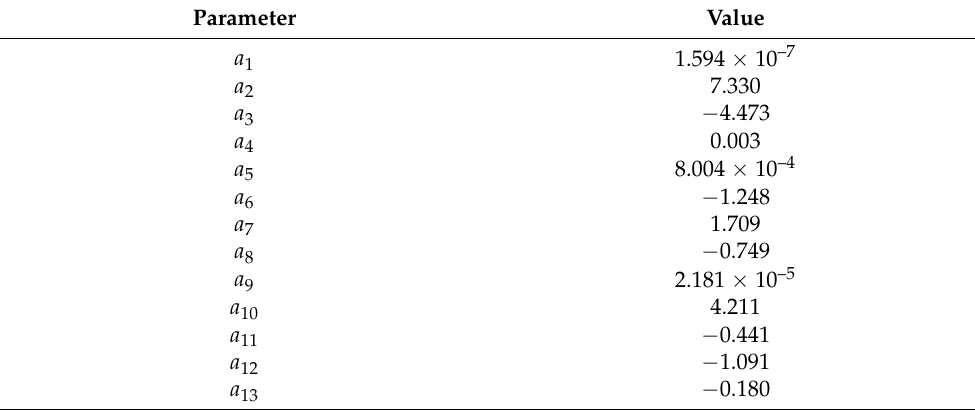
Table 4. Unknown parameter values obtained by